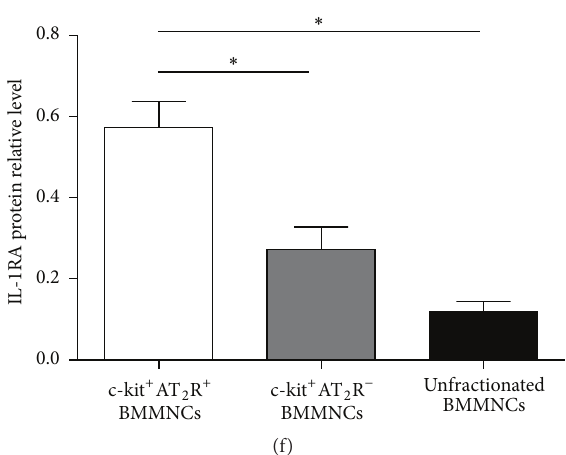
Figure2:ApoptoticrateofBMMNCsubsets.((a)-(b))AnnexinV/PIstainingofBMMNCcells. ∗ 𝑝 < 0.05;valuesaremeans ± SEM;BMMNCs subsets, 𝑛 = 3; ((c)–(f)) Cytokine protein array analysis of VEGF, HGF, and IL-1RA levels in BMMNC subsets. ( ∗ 𝑝 < 0.05, ∗∗ 𝑝 < 0.01; values are means ± SEM).